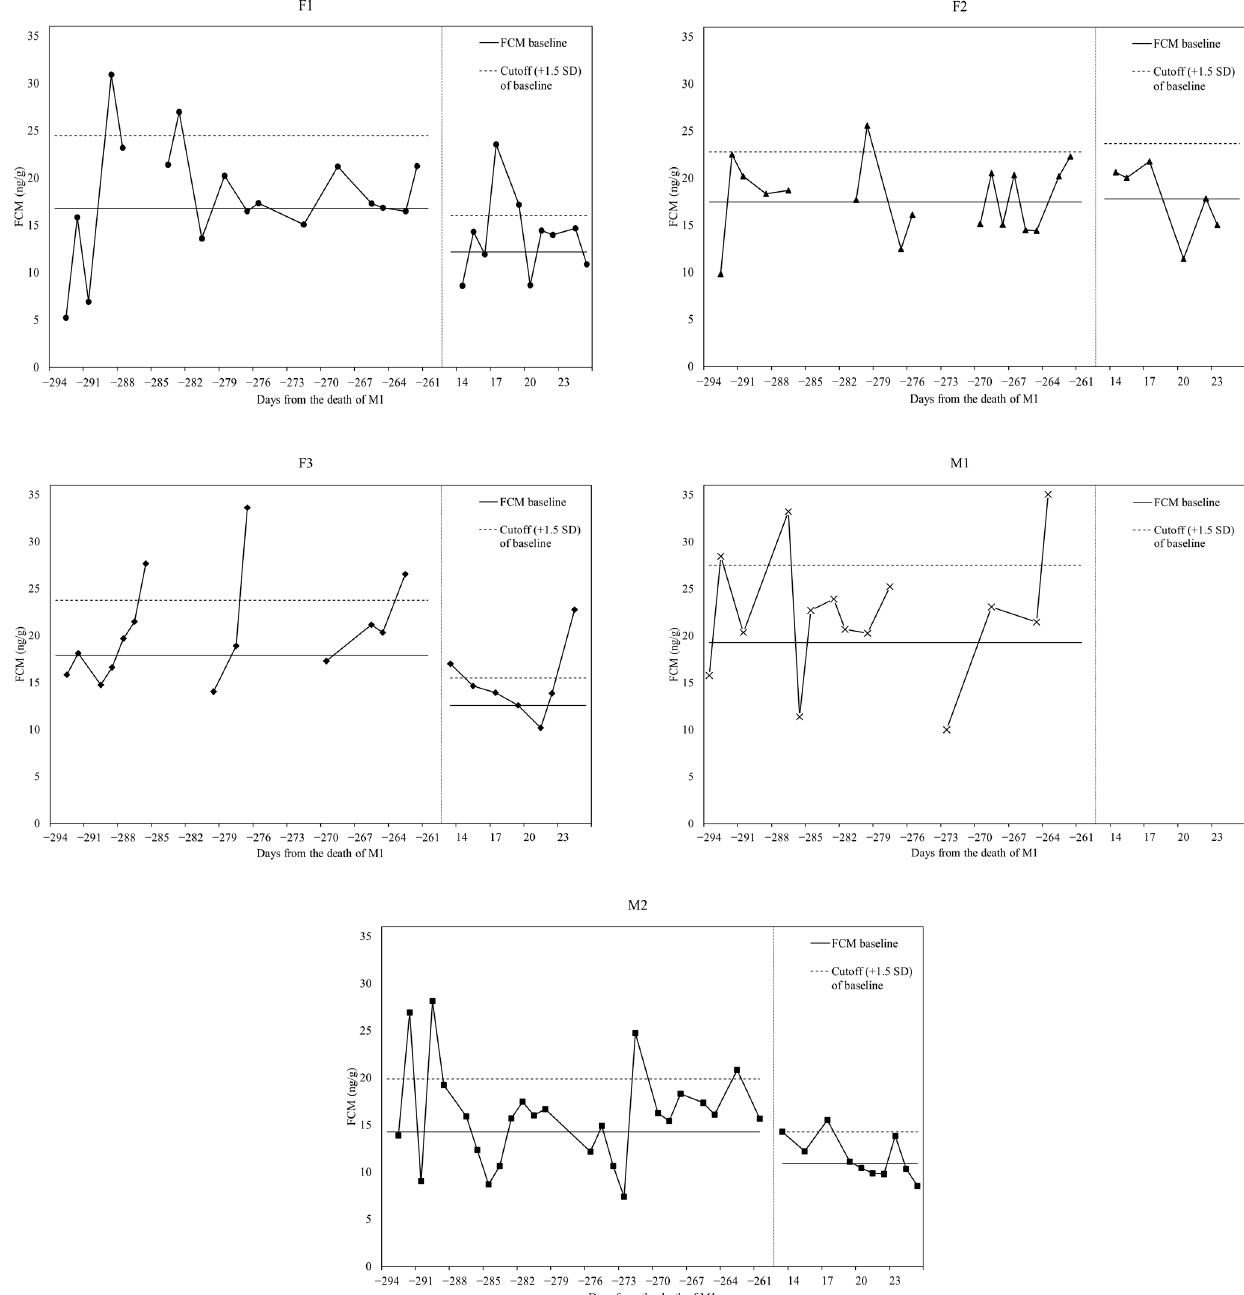
Figure 3. Longitudinal representation of fecal cortisol metabolite (FCM (ng/g)) levels before and after the death of the dominant male ( M1 ) in: ( F1 ) Female 1; ( F2 ) Female 2; ( F3 ) Female 3; ( M1 ) Male 1; ( M2 ) Male 2. The vertical dashed line symbolizes a jump in time from the sampling finalization before the death of M1 and sampling resumed afterward. The discontinuity of the line observed between several samples reflects those days where no wax color could be detected in the samples collected; thus, such fecal samples could not be identified or ascribed to an individual.